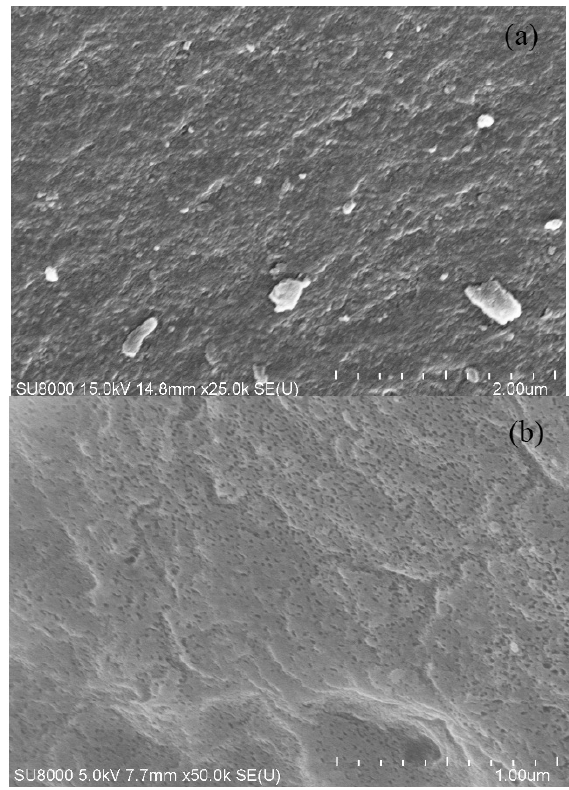
Figure 7. The SEM photographs of ( a ) unactivated carbon and ( b ) carbon activated by NaOH.